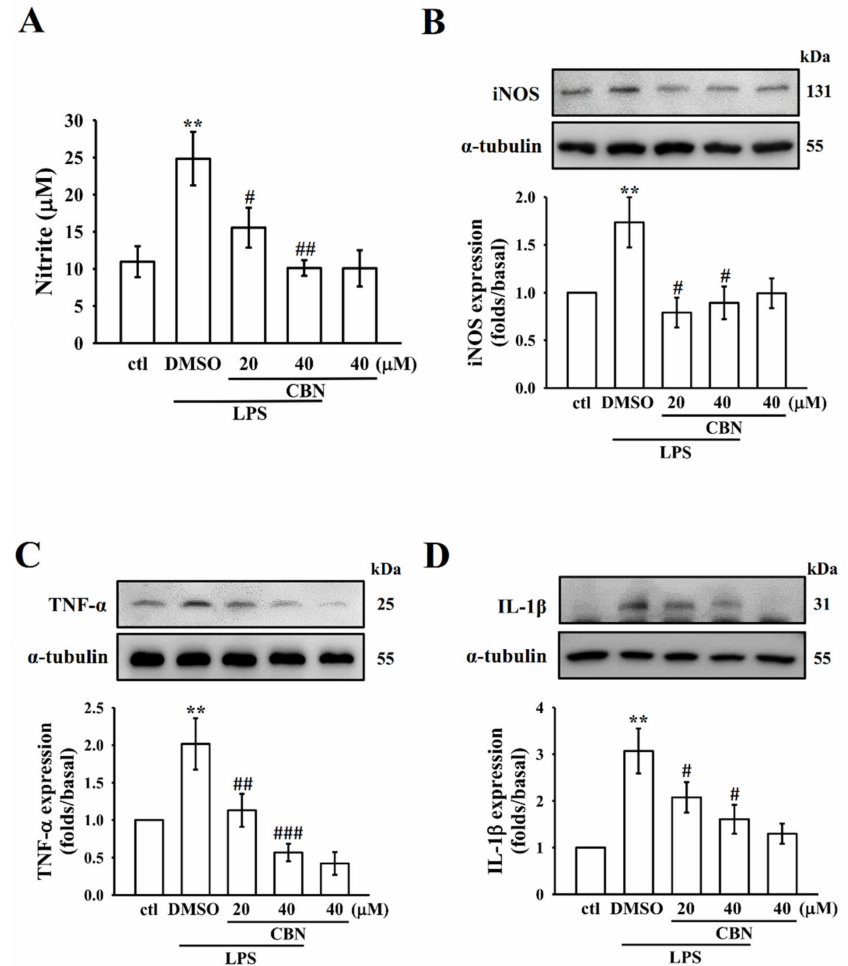
Figure 4. CBN inhibits NO production and expression of iNOS, TNF- α , and IL-1 β in LPS-induced RAW cells. The content of NO ( A ) and the expression of iNOS ( B ), TNF - α ( C ), and IL-1 β ( D ) proteins were assessed as defined in the Materials and Methods. Data presented are the means ± S.E.M. ( n = 4); ** p < 0.01, LPS vs. control cells; # p < 0.05, ## p < 0.01, and ### p < 0.001, LPS vs. CBN-treated